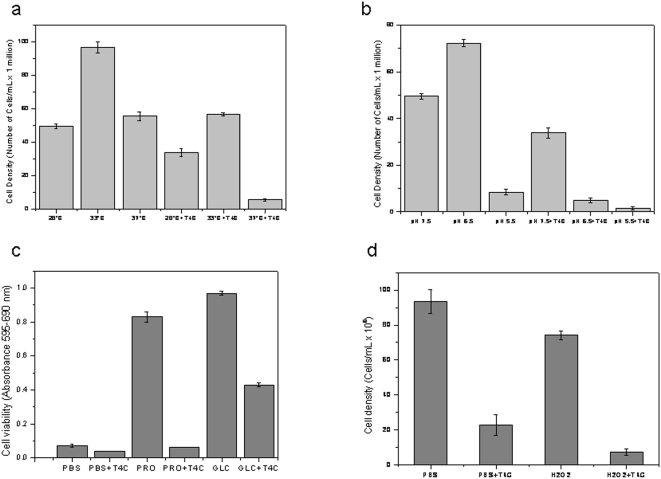
Response of epimastigotes at different stress conditions and T4C treatment.Panel a: the parasite density was measured at the 5th. day of growth, submitted or not to thermal stress (33°C and 37°C) and drug treatment (0.5 mM T4C). Panel b: the parasite density was measured at the 5th. day of growth, submitted or not to pH stress (pH 5.5 or 6.5) and drug treatment (0.5 mM T4C). Panel c) the parasite viability was measured by MTT assay after nutritional stresses performed by 72 h incubation in PBS, PRO and GLC, combined or not with the treatment with drug (0.5 mM T4C). Panel d: the parasites were submitted to oxidative stress by incubation in the presence of 160 µM H2O2 and the addition or not of drug (0.5 mM T4C). The effect of treatments and controls were measured by growing the parasites in LIT for five day and cell density, quantified.